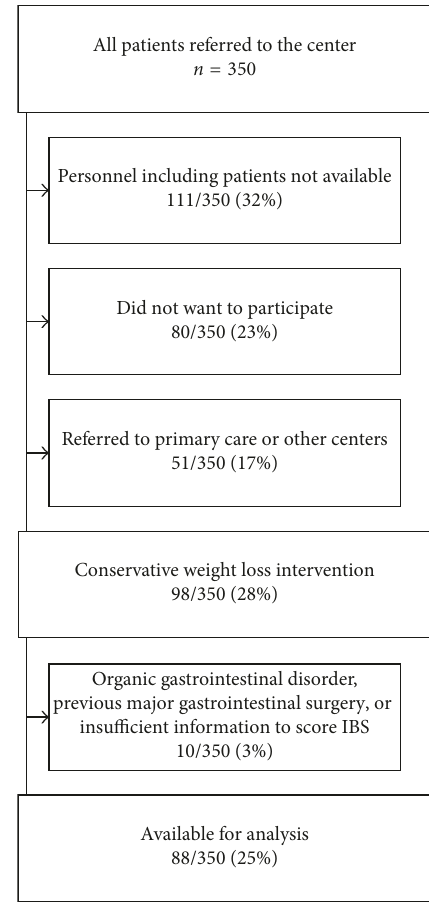
Figure 1: Inclusion of